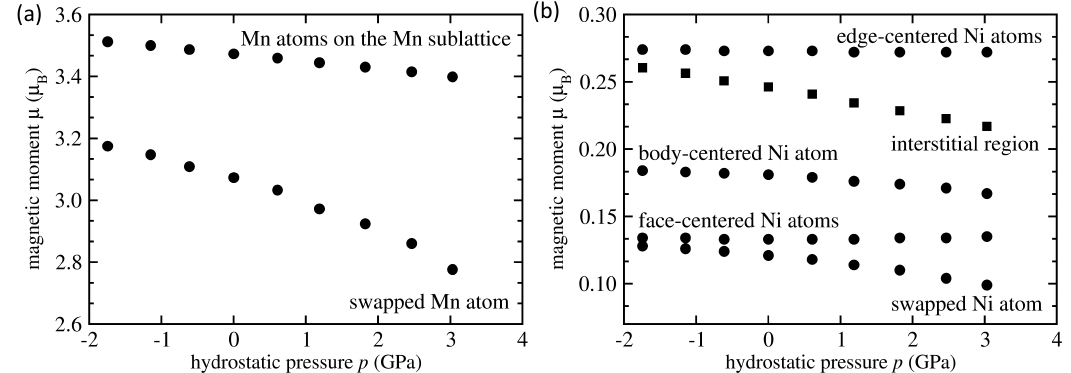
Figure 8. Computed changes of the magnetic moment of individual Mn atoms ( a ) as well as those of Ni atoms and in the interstitial region ( b ) in the case of FM-coupled single Mn-Ni